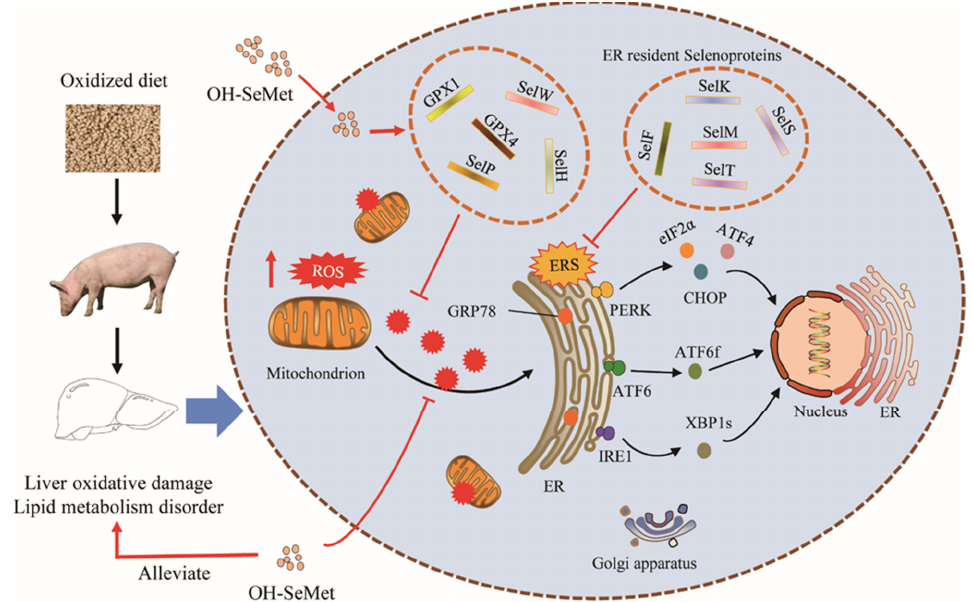
Figure 6. The proposed mechanism of OH-SeMet alleviates hepatic lipid metabolism disorder of pigs induced by oxidative stress. Supplementary Materials: The following supporting information can be downloaded at: www.mdpi.com/xxx/s1, Figure S1: Diet selenium concentration; Figure S2: The expression of se- lenotranscriptome in the liver; Table S1: Composition and nutrient levels of the basal diet; Table S2: The oxidation Characteristics of the diets; Table S3: Primers used for the Q-PCR; Table S4: The cor- relation analysis between the major selenoprotein-encoding genes and lipid metabolism markers.